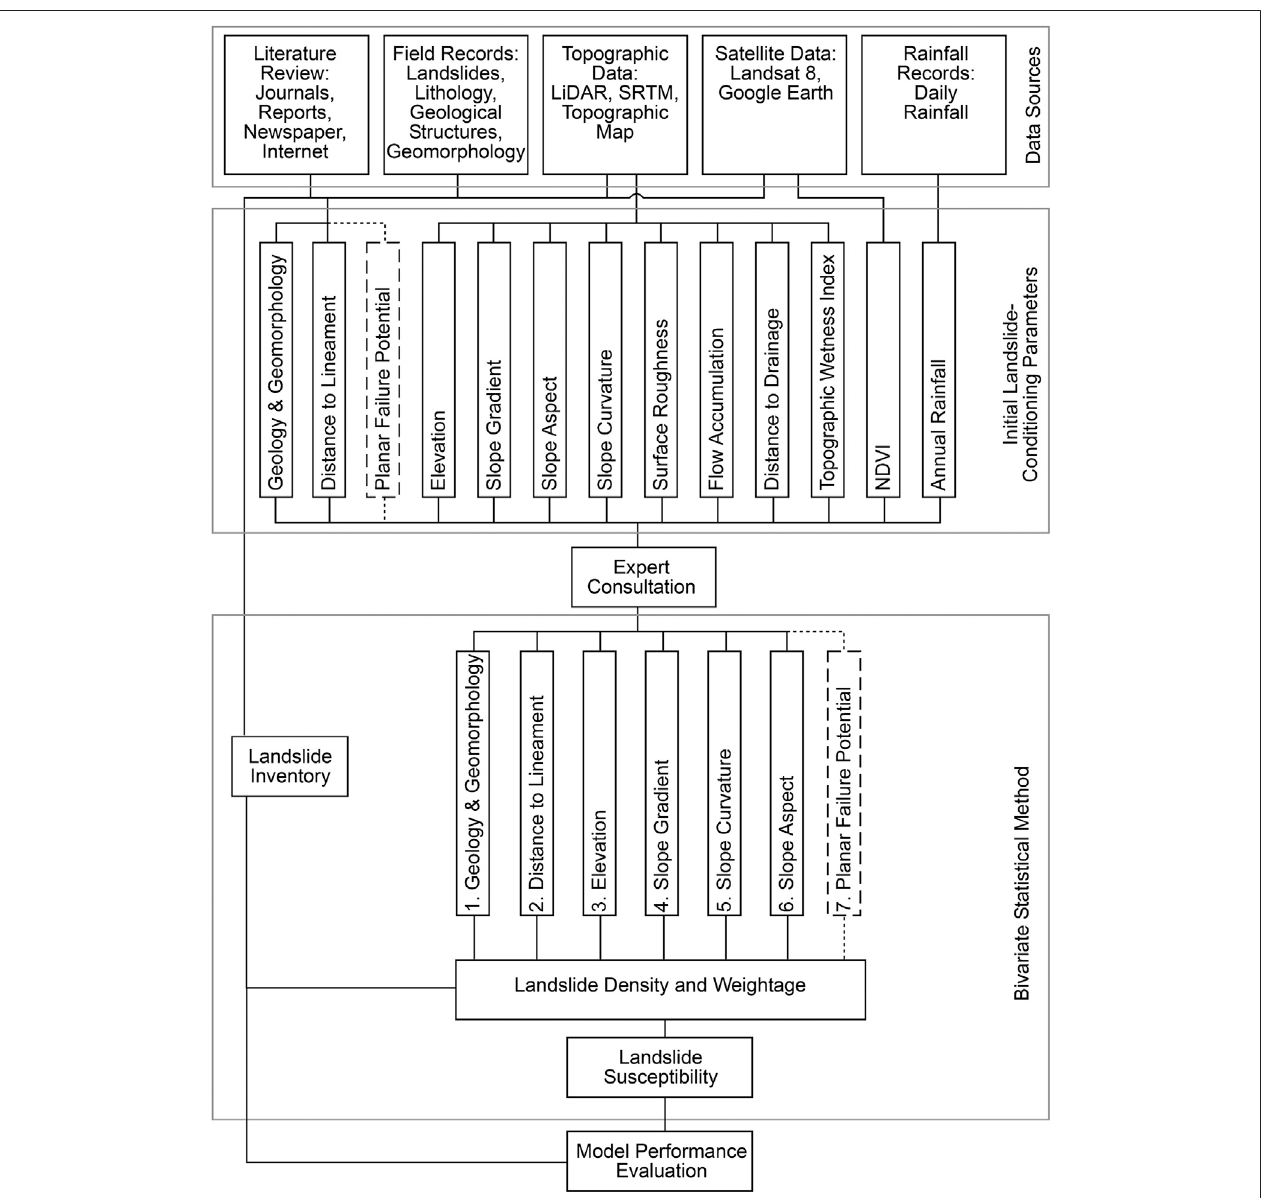
FIGURE 2 | Flow chart of the landslide susceptibility modeling using a hybrid approach, where expert opinion was used for the selection of landslide-conditioning parameters for bivariate statistical analysis.